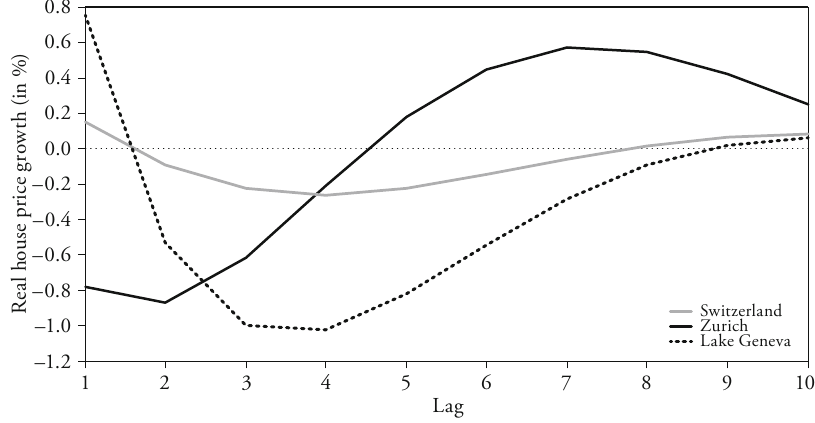
Figure 13: Regional Analysis: Response of House Prices to a Shock on Population Adjusted Housing Supply